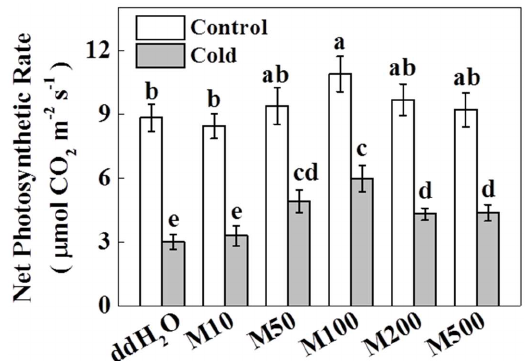
Figure 1. Net photosynthetic rate (Pn) as influenced by various concentrations of exogenous melatonin following cold stress. Two years-old tea ( Camellia sinensis L.) seedlings of Longjing 43 were pretreated with various concentrations of melatonin (10, 50, 100, 200, and 500 µM) and challenged with cold stress (−5 °C for 3 h) in temperature-controlled chambers. Pn was measured in mature tea leaves after a 3 h recovery from cold stress. Each data point presents the mean of six replicates (± S.D.(standard deviation)). Means denoted by different letters are significantly different ( p < 0.05) based on the Tukey’s test.